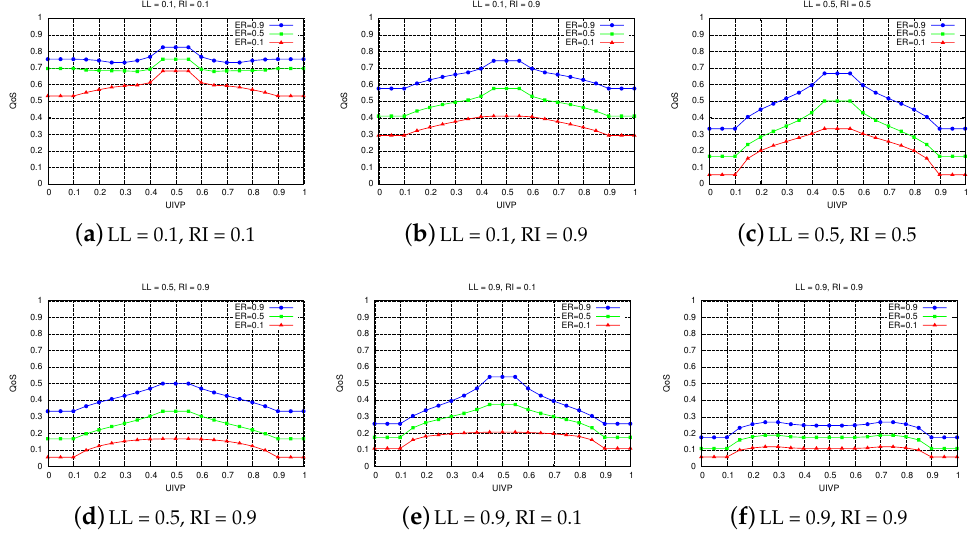
Figure 8. Simulation results for